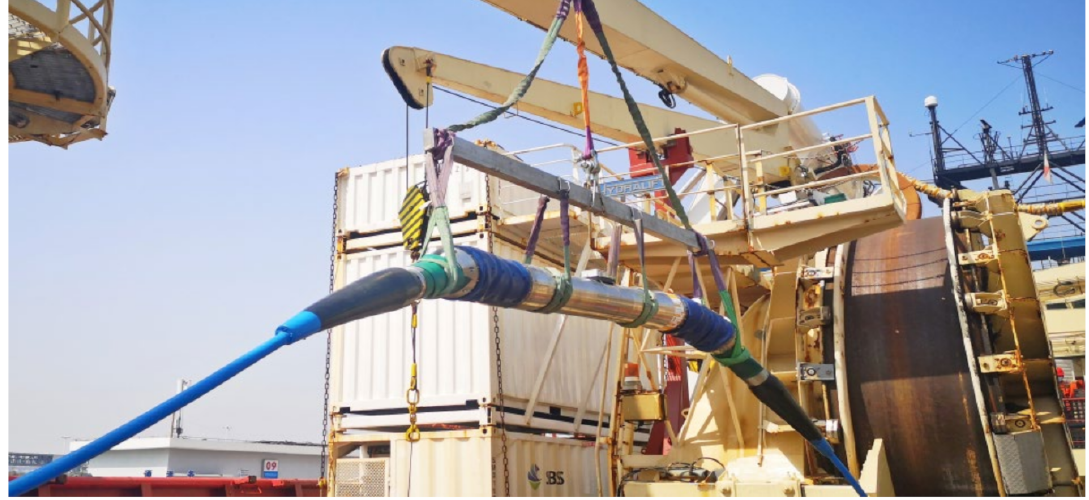
Figure 19. The Hainan to Hong Kong Express (H2HE) cable system will be a milestone in tech- nological innovation as the world’s first 16 fiber pair repeated system, incorporating the HMN fifth-generation space-division multiplexing (SDM) technology